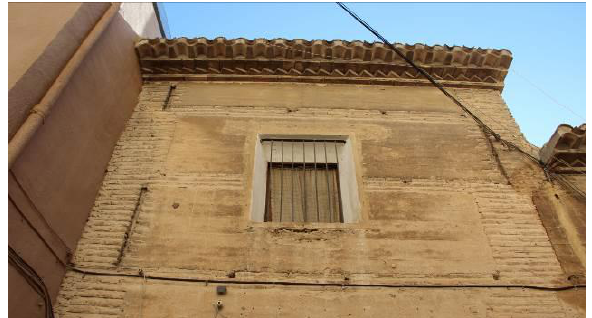
Figure 15. Building on calle Monjas no. 54 (residence within the Real Monasterio de la Encarnación) (Source: authors).